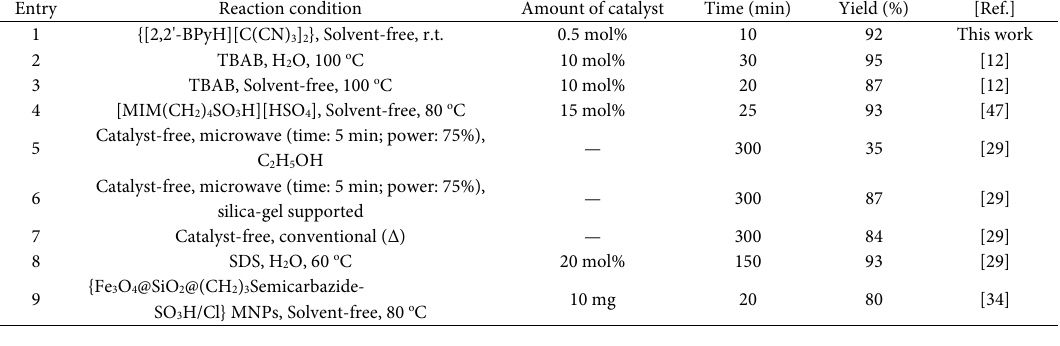
Table 5. Comparison of the results of the condensation reaction of 4-chlorobenzaldehyde with 4-hydroxycoumarin catalyzed by {[2,2'- BPyH][C(CN) 3 ] 2 } with those attained by the reported catalysts.